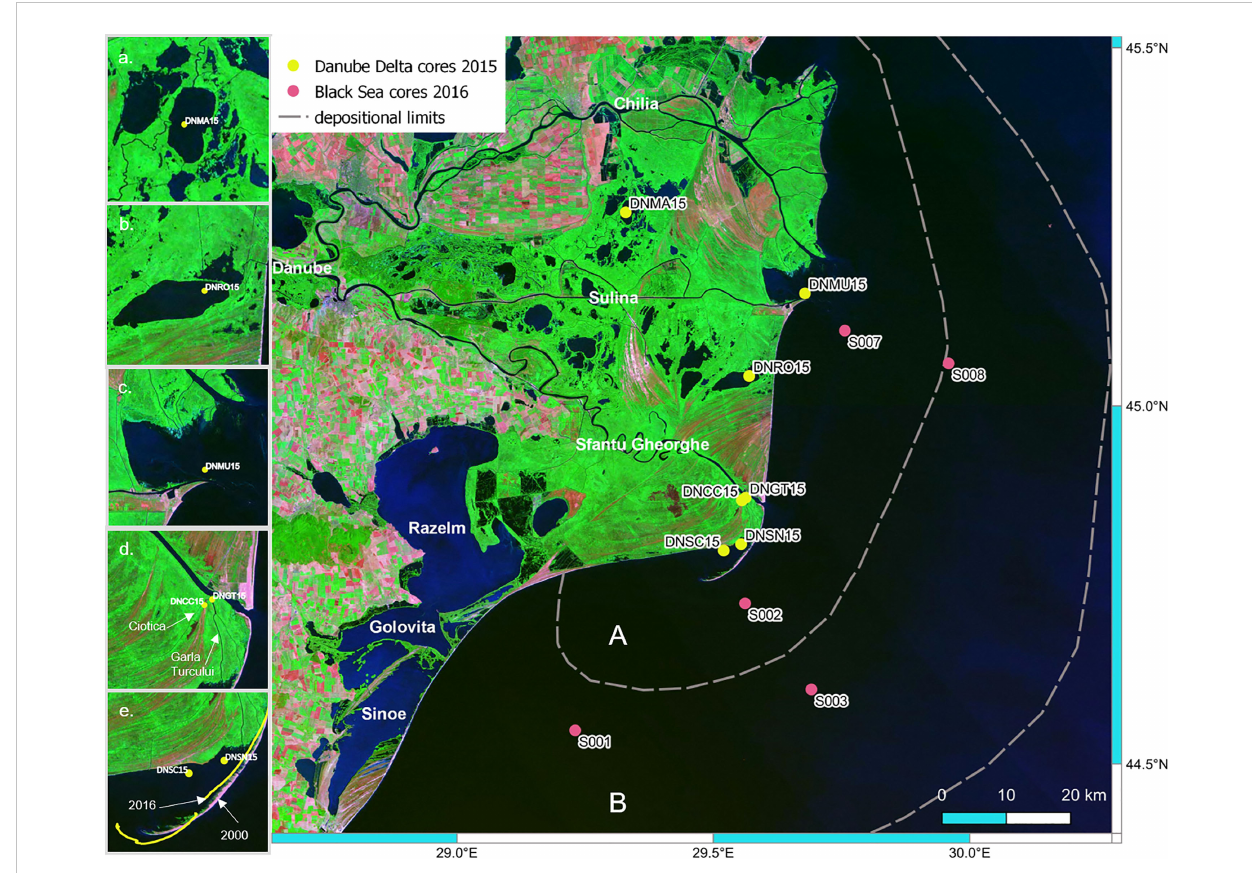
FIGURE 2 The Danube Delta and the NW Black Sea shelf, with the locations all cores used for this study (false colour Landsat images). The dotted lines represent the depositional limits of the delta front (A) and prodelta (B) (modi fi ed, after Panin and Jipa, 2002). The exact location of all cores is presented in Table 1. Detailed locations of the cores retrieved in the Danube Delta are: (a) Lake Matita, (b) Lake Rosu, (c) Musura Lagoon, (d) Garla Turcului and Canal Ciotica, (e) Sahalin Lagoon (note Sahalin sand bar position in 2000 and 2016; GeoEcoMar, unpublished data).